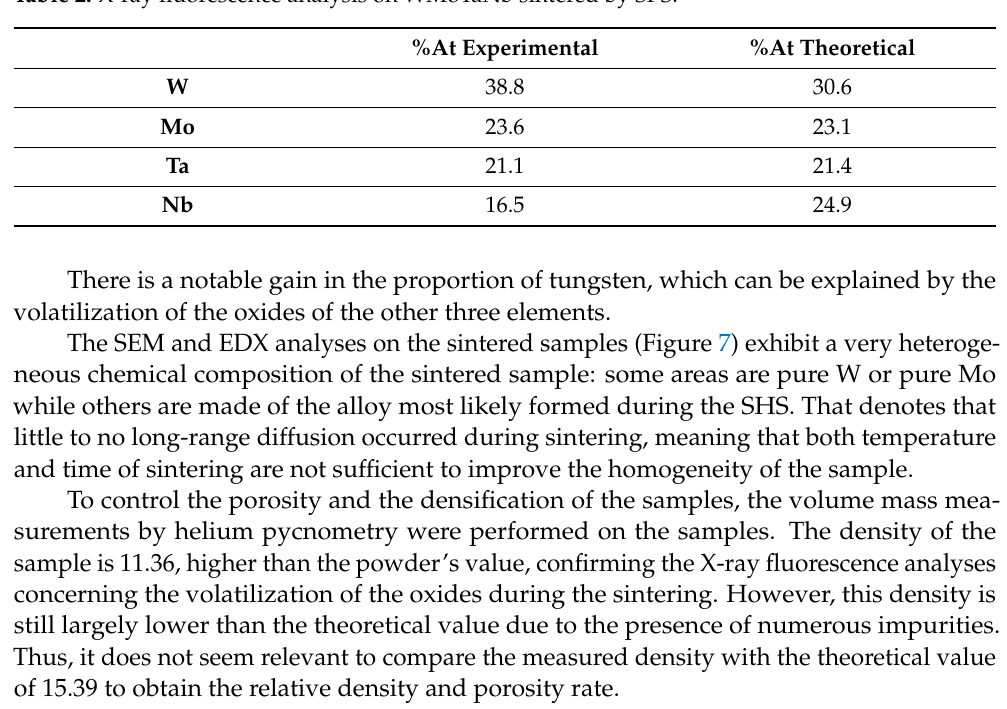
Figure 6. X-ray diffractogram of WMoTaNb sintered by SPS. X-ray fluorescence analysis was performed on the sample after sintering (Table 2). Table 2. X-ray fluorescence analysis on WMoTaNb sintered by